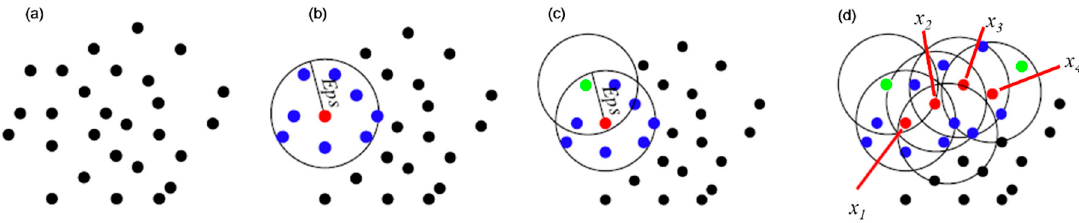
Figure 2. Key definitions used in DBSCAN approach. ( a ) Shows a cluster of points. The red point in ( b ) is a core object. The green point in ( c ) is a border point. In ( d ) all red points are density ‐ reachable objects.